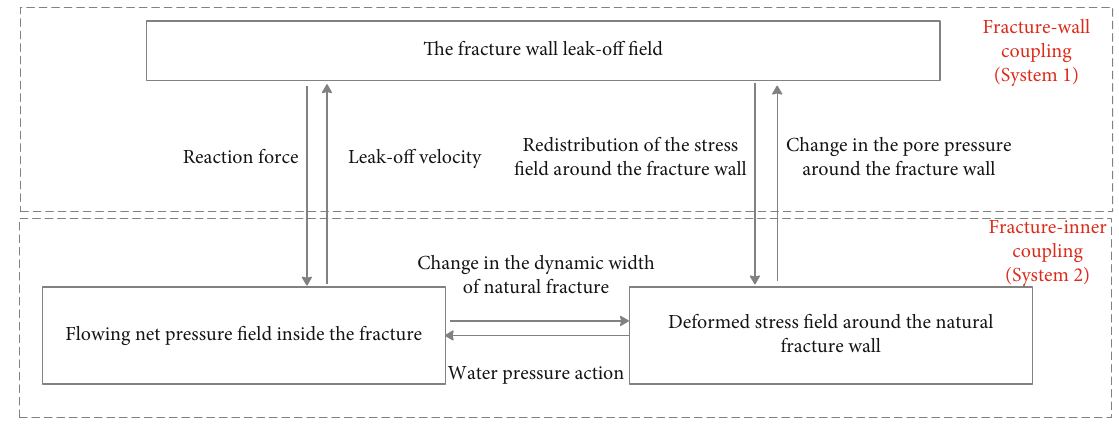
Figure 4: Schematic diagram of dual-system